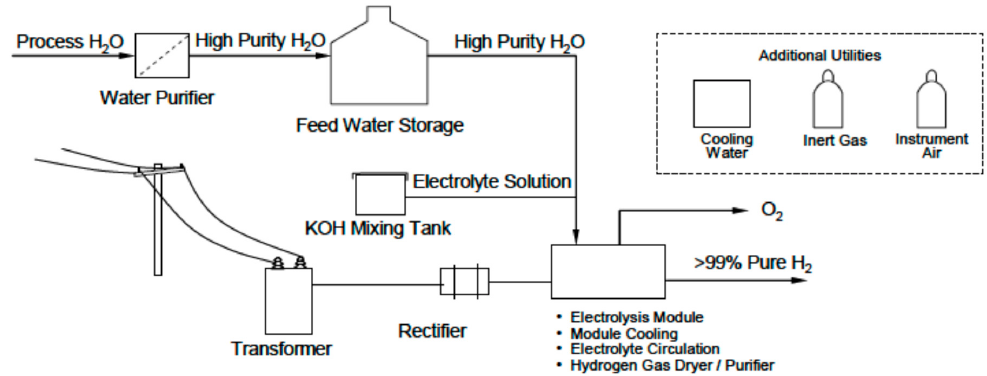
Figure 2. Electrolysis process flow diagrams [13].